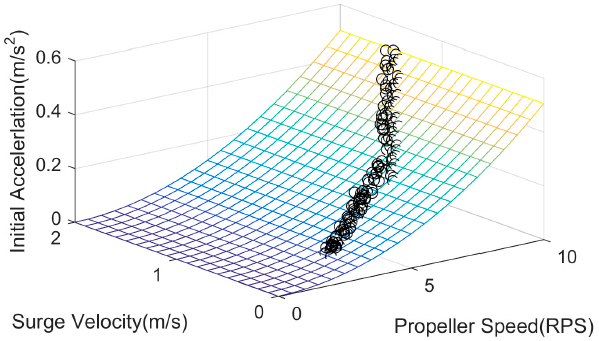
Figure 5. The flow diagram of the test for collecting initial acceleration, surge velocity and propeller speed.